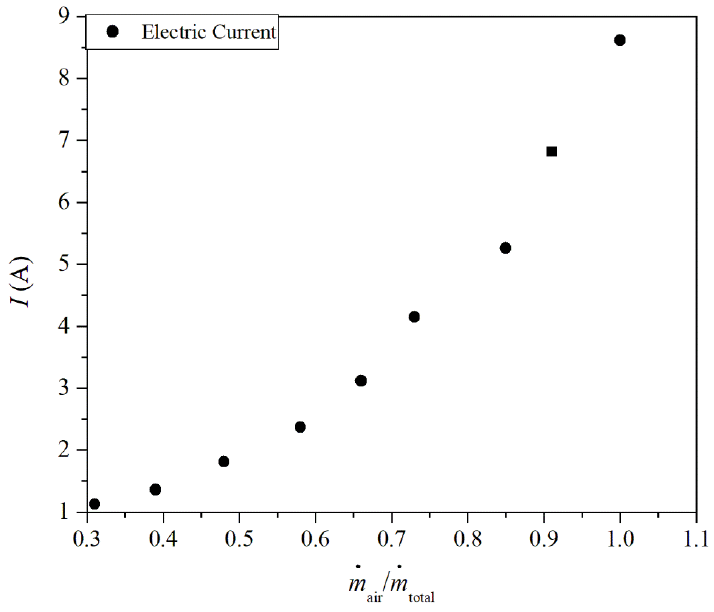
Figure 5. Variation of the electric current demand by the fan motor of the evaporative condenser as a function of modification of operating rotation. function of modification of operating